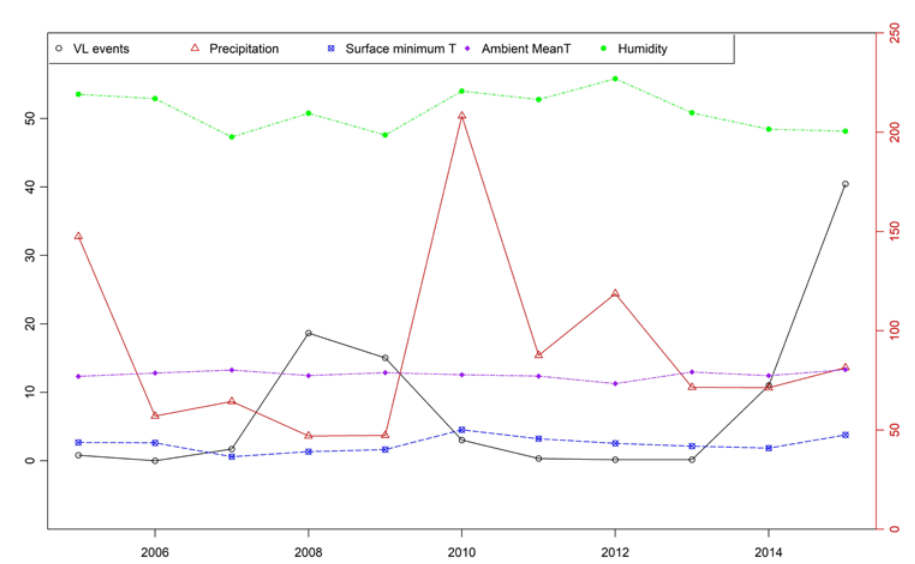
Figure 4. Yearly mean values of VL events, precipitation, surface land minimum temperature, and relative humidity.